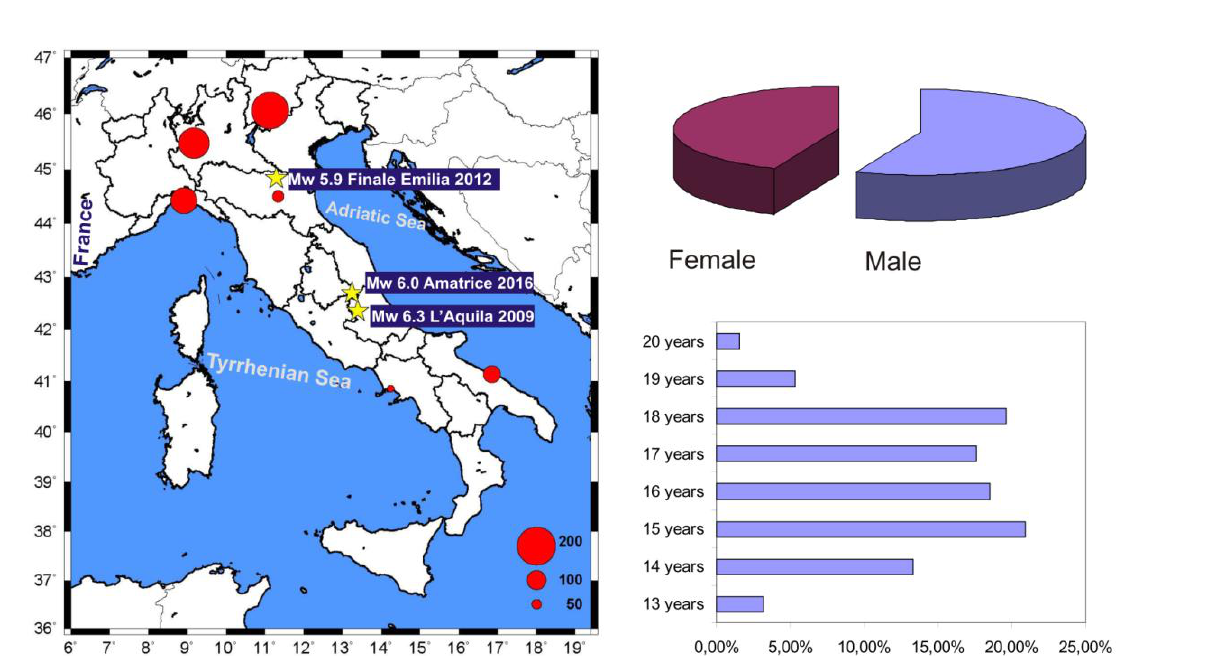
Figure 1 . Left panel . Regions where data were collected. Most questionnaires were filled in Northern Italy. The stars are the location of the most recent, destructive earthquakes in Italy. Right panels. Top, distribution of the sample with sex. Bottom, age of the